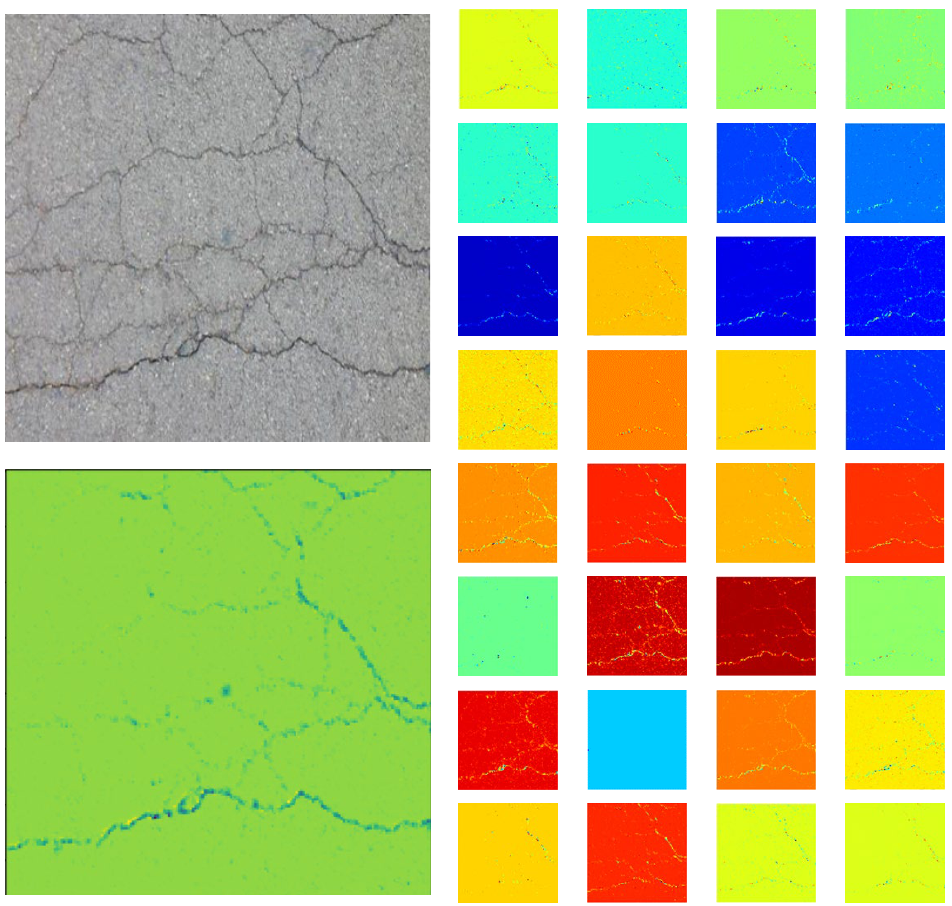
Figure 10. Input image ( top left ), feature maps extracted by involution in the second stage in Rednet-50 [41], and fused image of feature maps ( bottom left ). The pictures are represented using 32 bits.